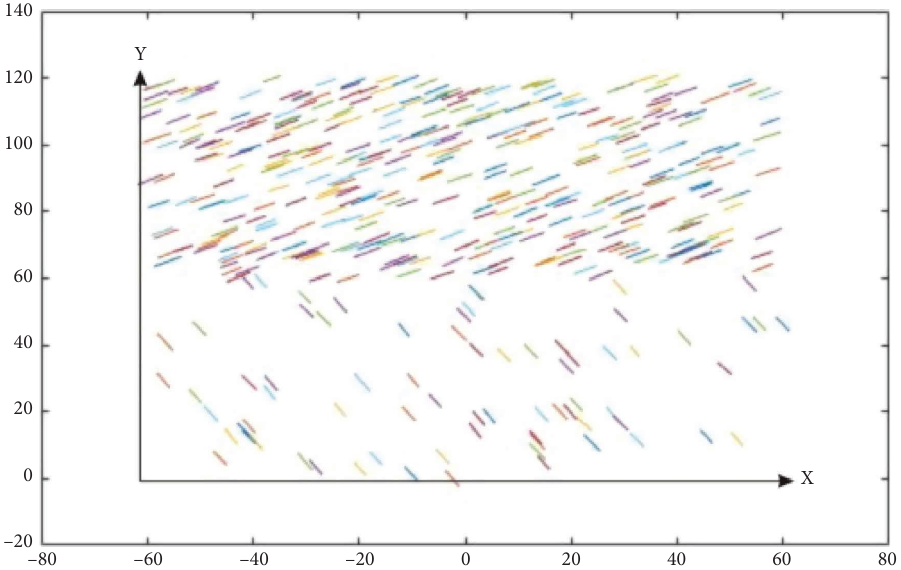
Figure 2: Schematic diagram of the joint network of two stratigraphic combinations. Table 1: Characteristics of joint distribution parameters.